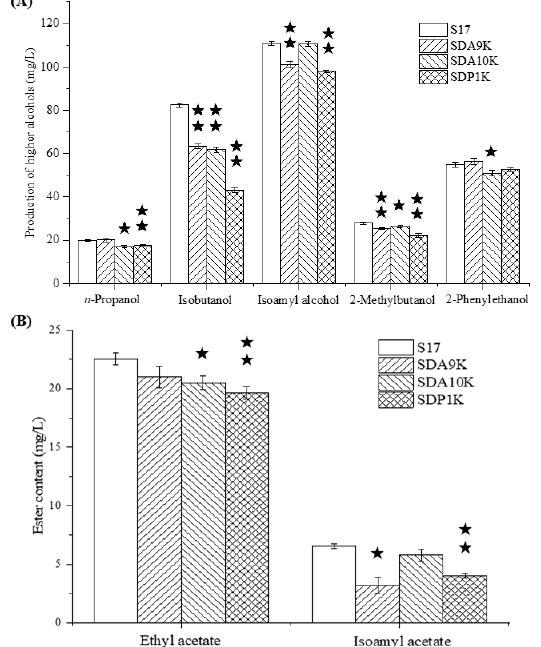
Figure 5. ( A ) Higher alcohol production by GAT1 target genes double allele deletion mutants and parental strain S17. ( B ) Esters production by GAT1 target genes double allele deletion mutants and parental strain S17. Data are the averages of three independent experiments. Error bars represent ± SD. ★★ p < 0.01, ★ p < 0.05.